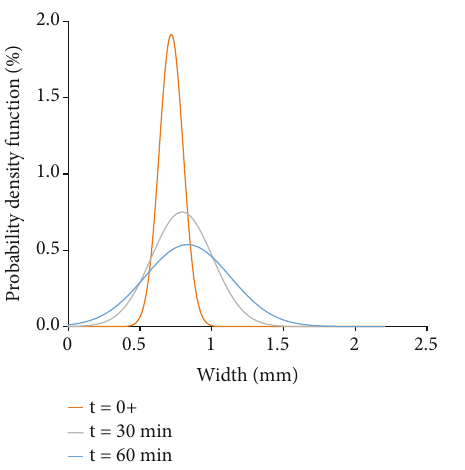
Figure 15: Probability density function of the fracture width at di ff erent time